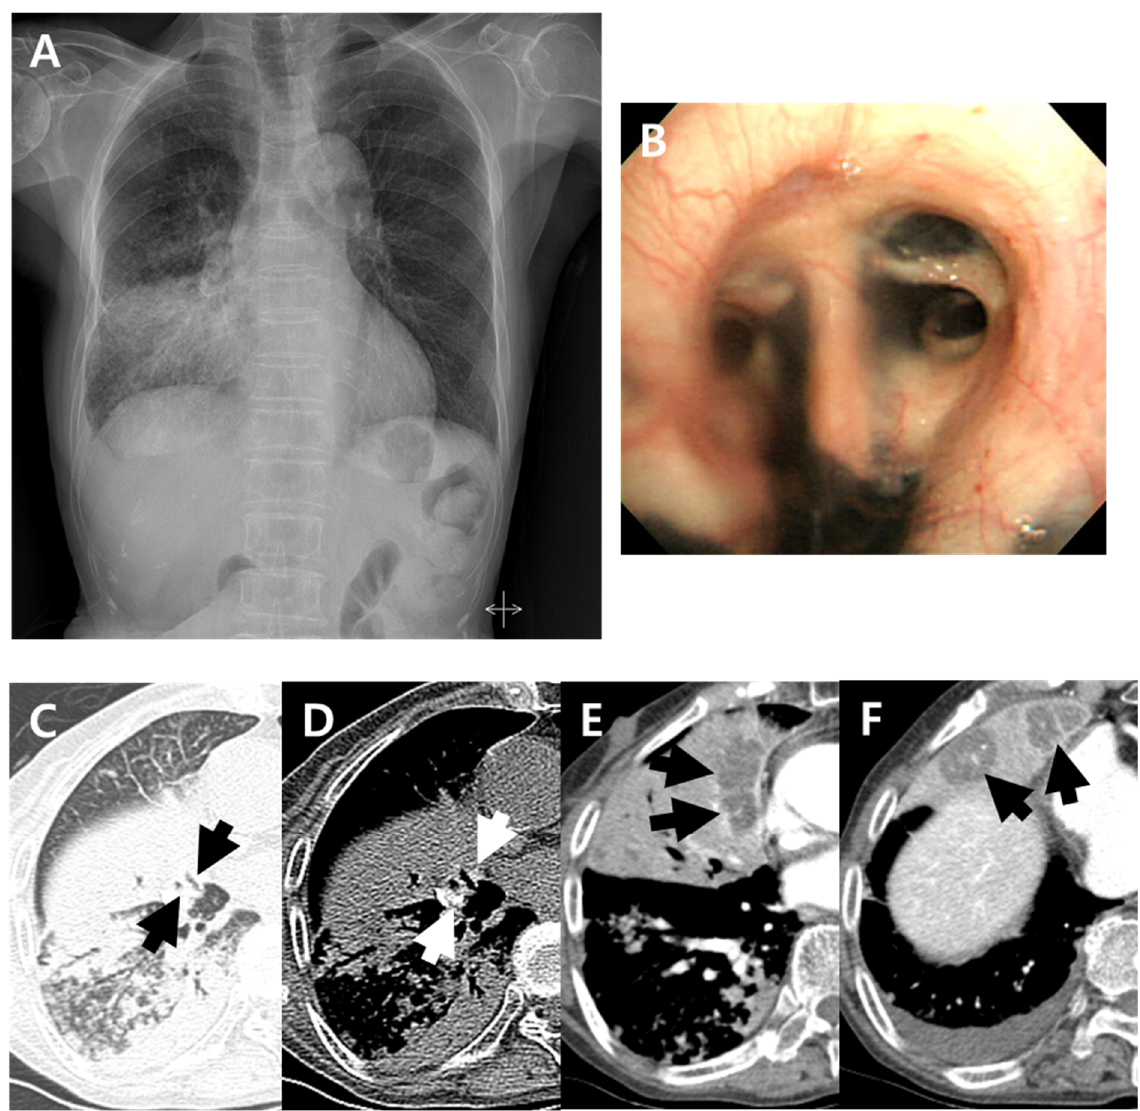
Figure 1. A 79-year-old woman with pulmonary tuberculosis and underlying bronchial anthracofibrosis presented with an abnormal chest plain radiograph. ( A ) Chest plain radiograph showed consolidation and ill-defined nodular opacities in right lower lung field with lower lobe predominance. ( B ) Bronchoscopic image showed luminal narrowing at segmental bronchi of right middle lobe with multifocal deposition of black pigmentation, and bronchial anthracofibrosis was diagnosed. ( C , D ) Non-enhanced axial CT scan showed bronchostenosis (black arrows) at medial and lateral segmental bronchi of right middle lobe and peribronchial hyperattenuation (white arrows) around medial and lateral segmental bronchi of right middle lobe. These CT findings suggested bronchial anthracofibrosis. ( E , F ) Contrast-enhanced axial CT scan showed internal low-density areas (arrows) within atelectasis of right middle lobe. These findings were atypical CT findings of pulmonary tuberculosis, which cannot be suspected of TB. By the way, clustered micronodules with tree-in-buds and consolidations in right lower lobe were shown on the axial CT scan which were well known typical CT findings of pulmonary tuberculosis. CT = computed tomography.